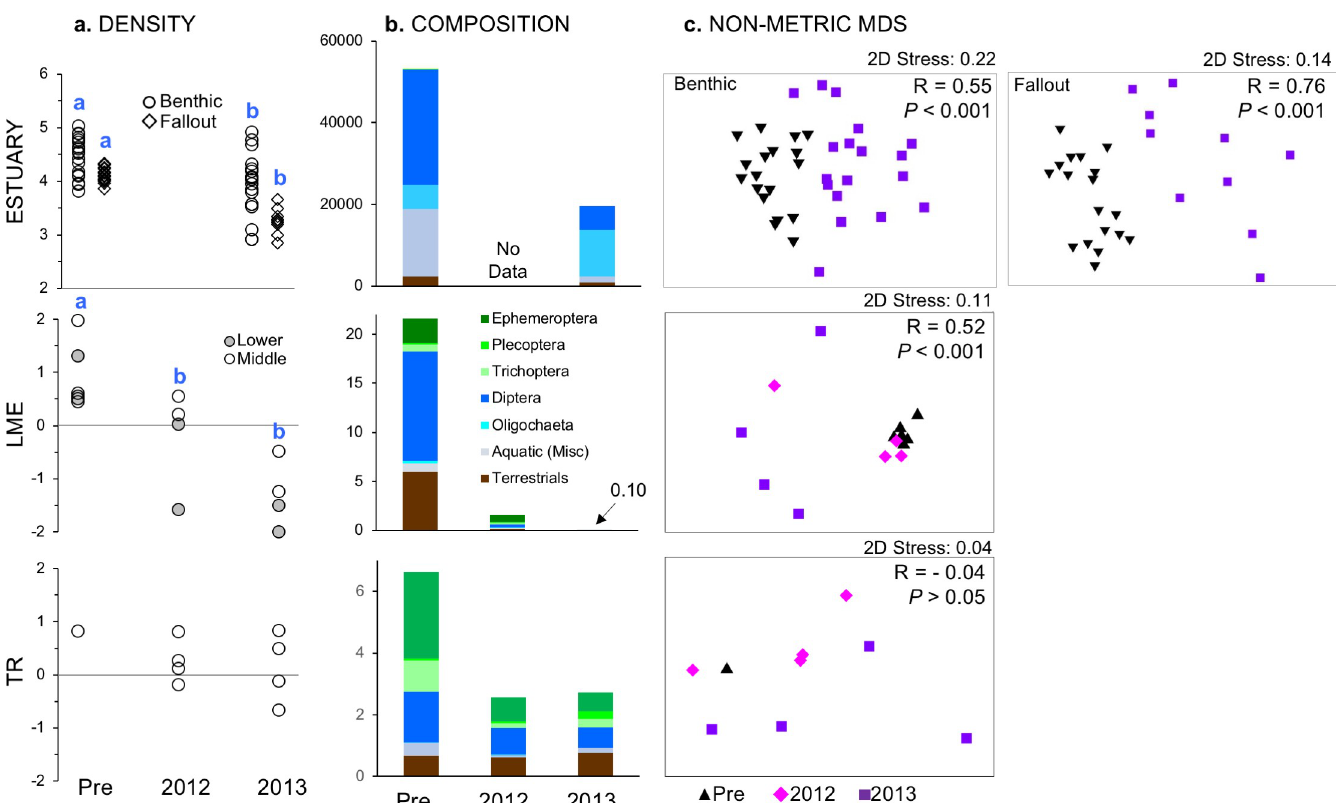
Fig 3. Spring invertebrate density by section and sample year. Data are plotted as (a) log density by site, (b) composition by major taxonomic groups (section means), and (c) nMDS, with global sample statistic and significance for one-way ANOSIM by year; note that ordinations with 2D stress values > 0.2 may not adequately represent data structure [36]. For panel a, different letters indicate significant year differences ( P < 0.05) within a section based on Tukey’s HSD. Note that y-axis range varies by section, and that collection methods varied between estuary and river sections. All data are based on numerical density: counts per m 2 for estuary and per m 3 for all other sections. For estuary data, composition data in panel b is combined for benthic and fallout